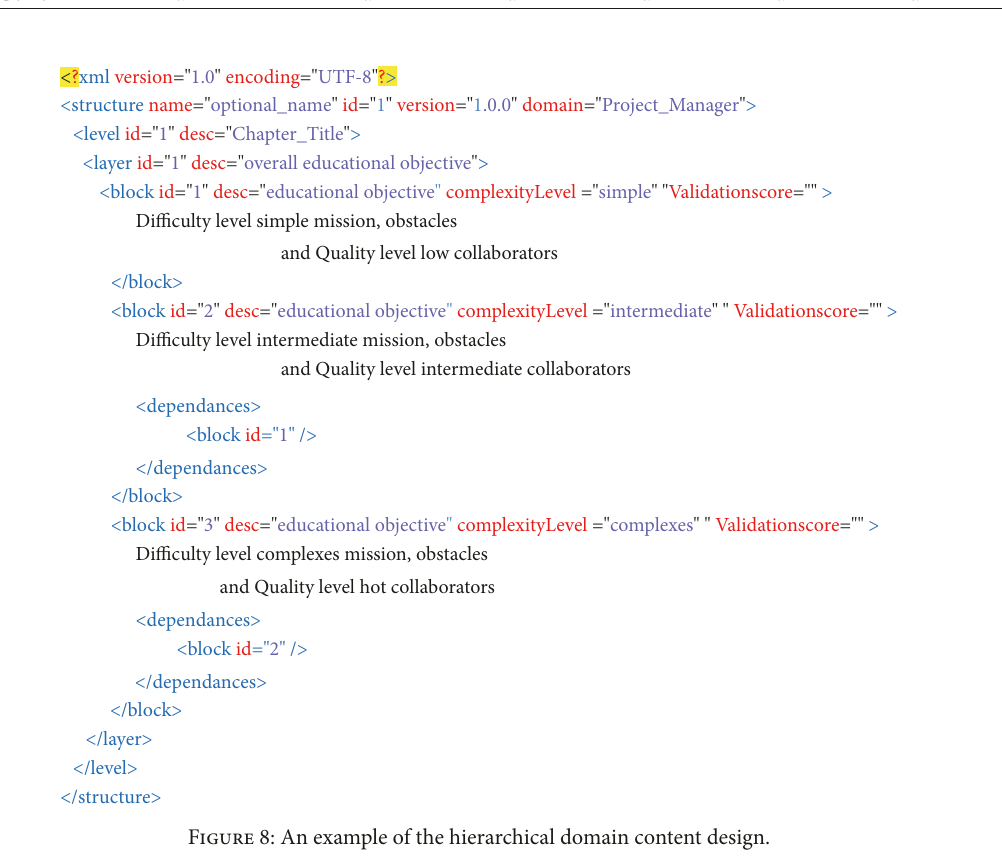
Figure 8: An example of the hierarchical domain content design.